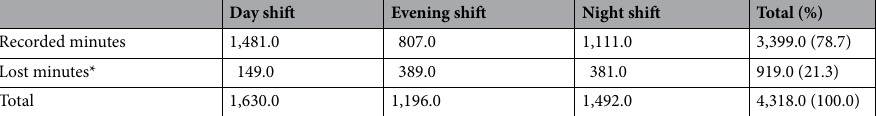
personal time (e.g., eating, talking, resting), movement, and research, a total of 1,975 activities (3,219.4 min) were included in the analysis. Among these, 984 (49.8%) took place during the day shifts, 508 (25.7%) during